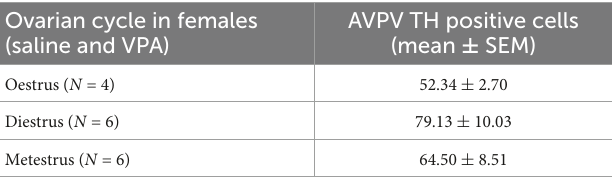
TABLE 1 Average number of anteroventral periventricular nucleus (AVPV) tyrosine hydroxylase (TH) positive cells in females sacrificed in three different ovarian cycle. Control and VPA females were pulled